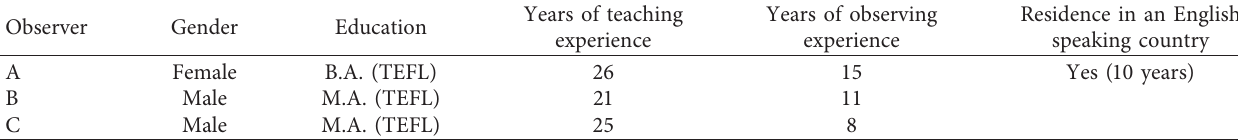
Table 1: Observers’ background information.